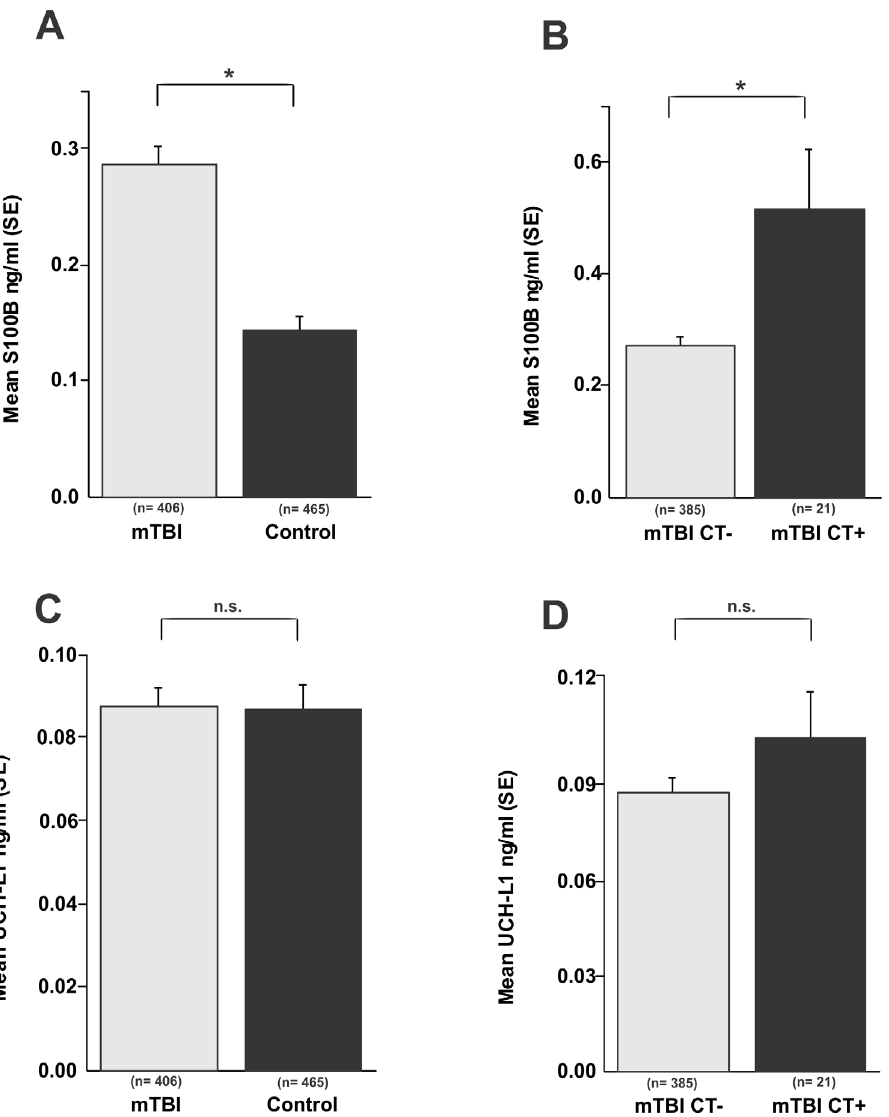
Figure 5. Lack of significant correlation between serum UCH-L1 levels and a diagnosis of mild TBI. A ) S100B levels are significantly elevated in patients with a diagnosis of mild TBI compared to healthy controls ( p , 0.01) and, B ) S100B levels correlate with post-traumatic findings on head CT ( p , 0.01). C ) and D ) UCH-L1 levels remain unchanged in patients with a diagnosis of mTBI compared to controls as well as in those patients with positive findings on head CT. Significance is determined by ANOVA and denoted as (*) for p ,